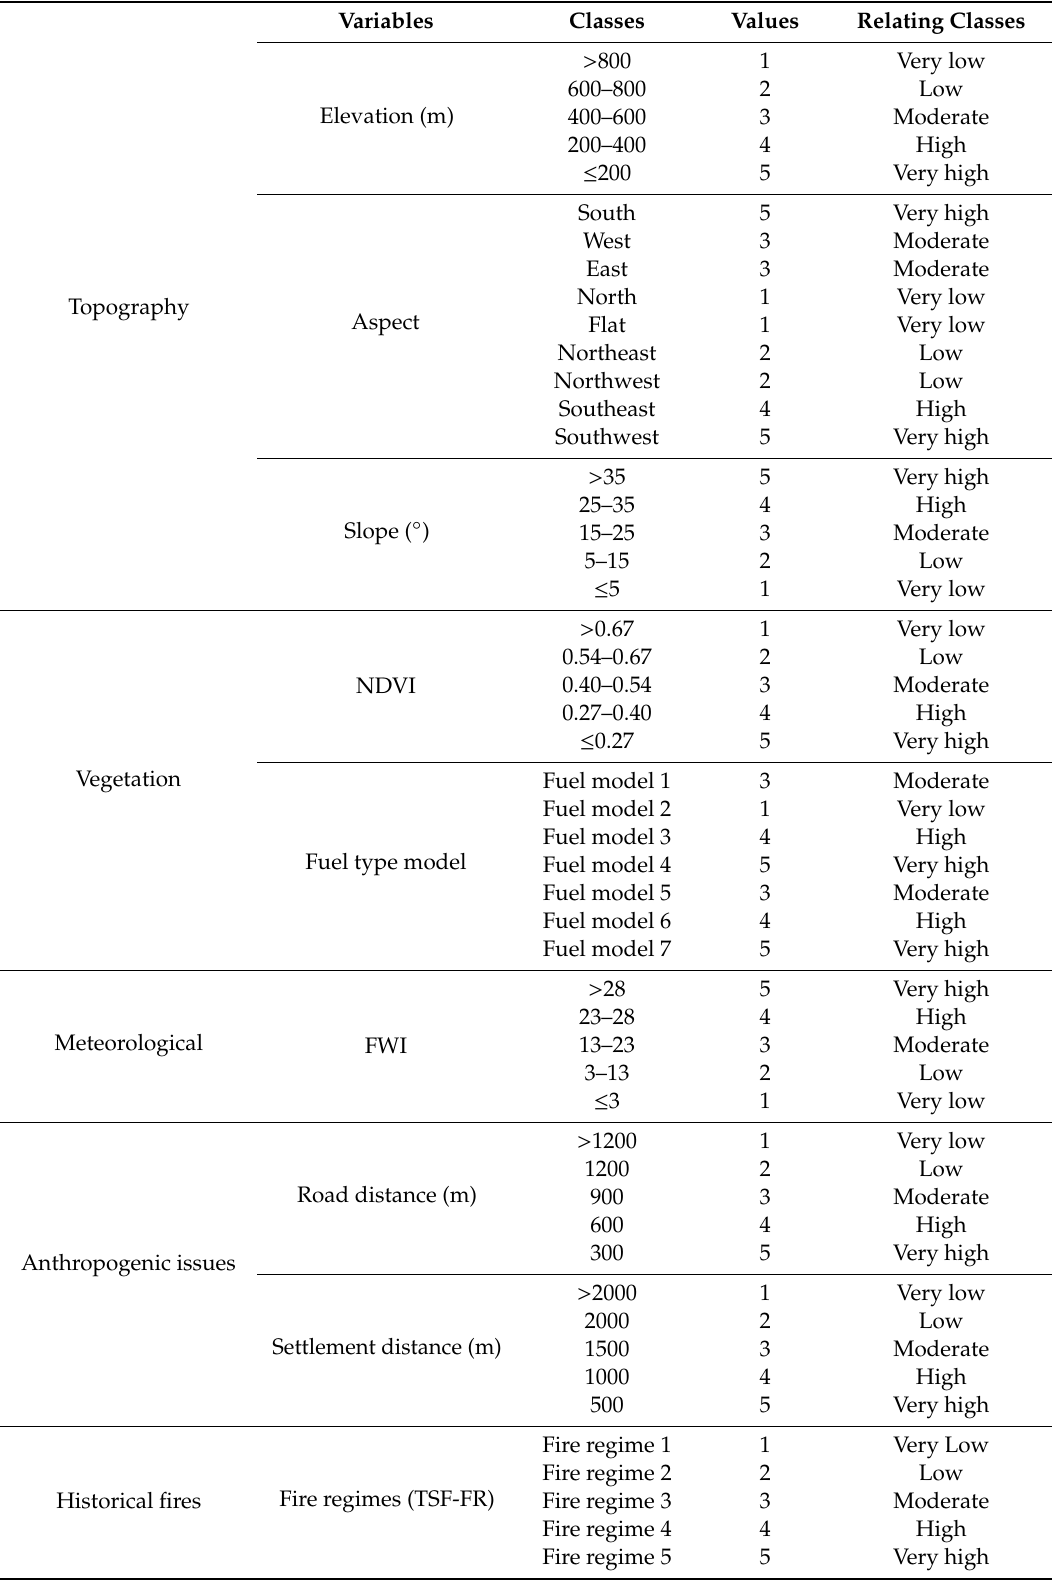
Table 2. Values and relating classes assigned to variables of forest fire risk